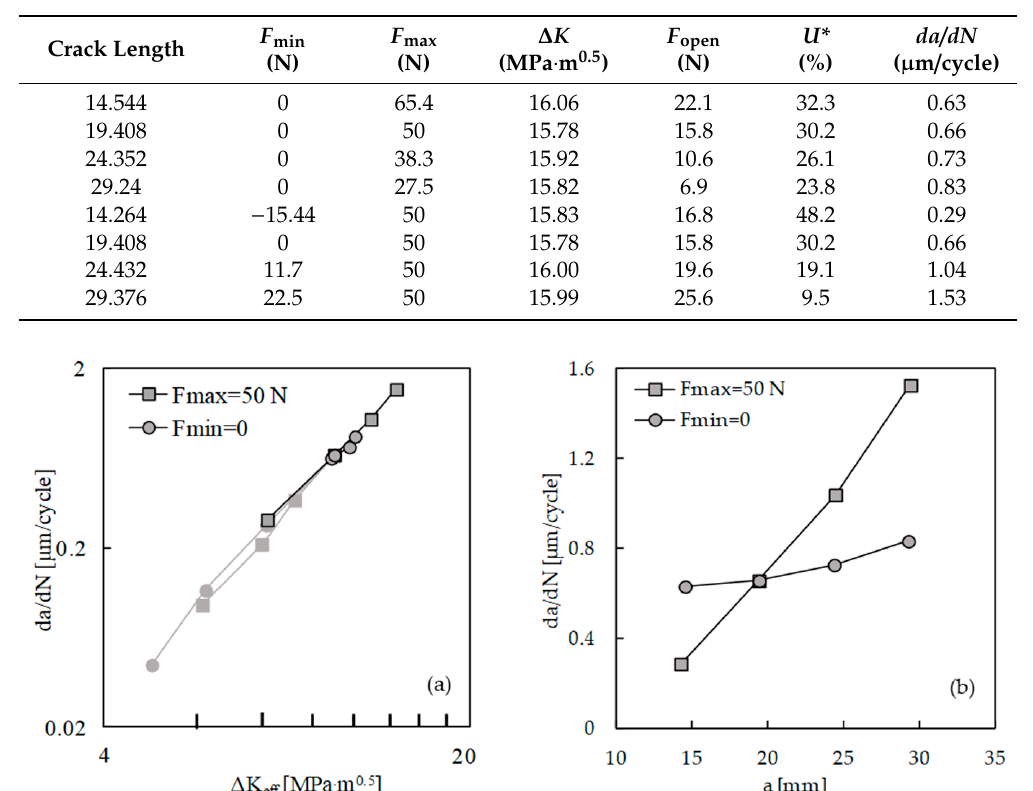
Table 3. Loading cases with di ff erent crack size and nearly constant ∆ K .